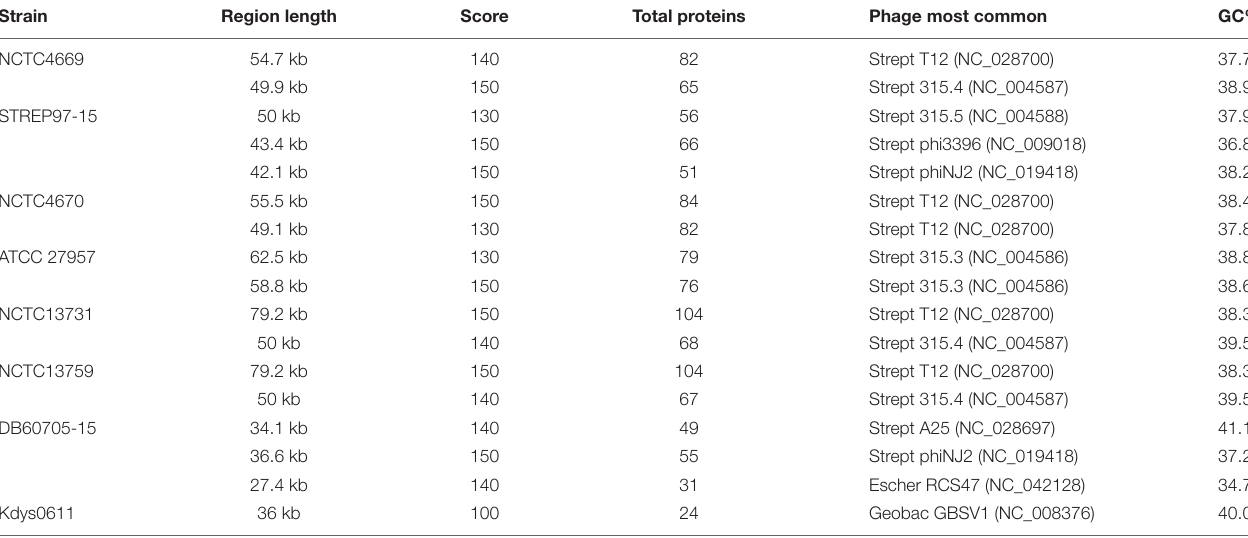
Bovine SDSD isolates: ATCC 27957, NCTC13731, NCTC4669, and NCTC4670. Human SDSD strains: DB49998-05 and DB60705-15. Fish SDSD strain: SDSD Kdys0611 and SDSD STREP97-15. GC, guanine–cytosine; SDSD, S. dysgalactiae subsp.